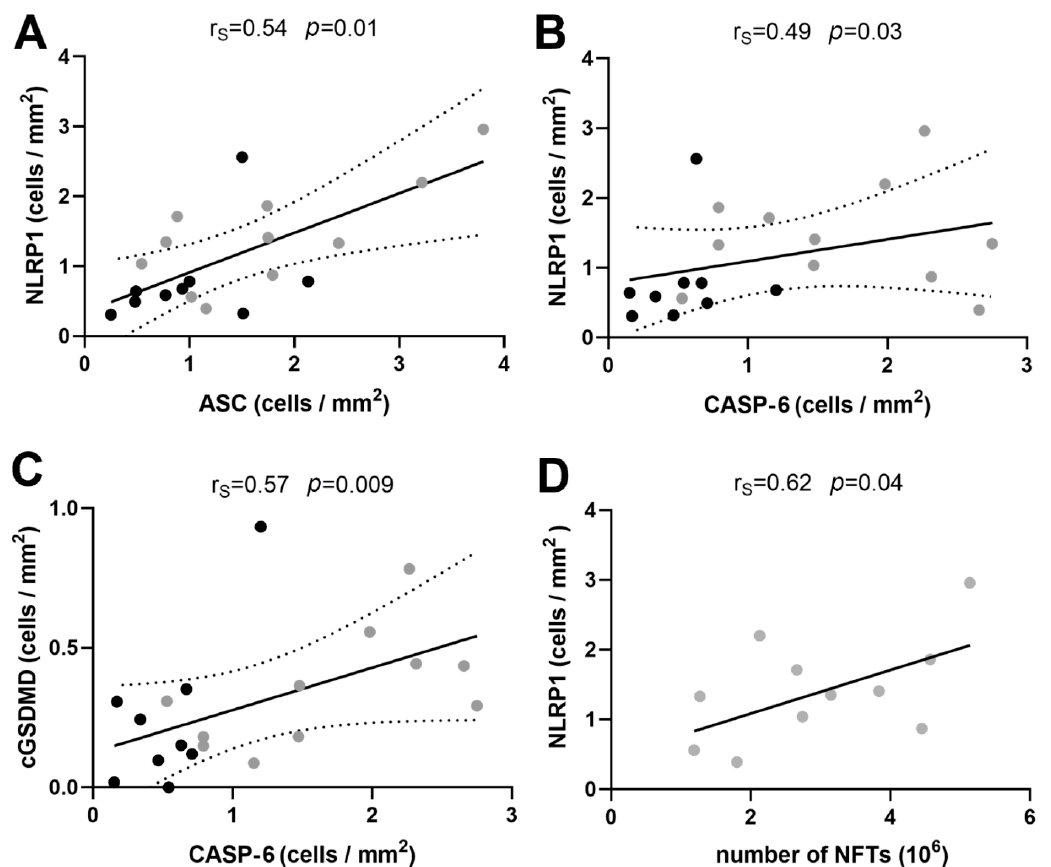
Figure 2. ( A ) Correlation between NLRP1 and ASC immunoreactivity. ( B ) Correlation between NLRP1 and CASP-6. ( C ) Correlation between cGSDMD and CASP-6. Dotted lines represent the 95% confidence interval. ( D ) The total number of NLRP1-immunoreactive neurons per area of hippocampal formation tissue significantly positively correlated with the total number of NFTs.